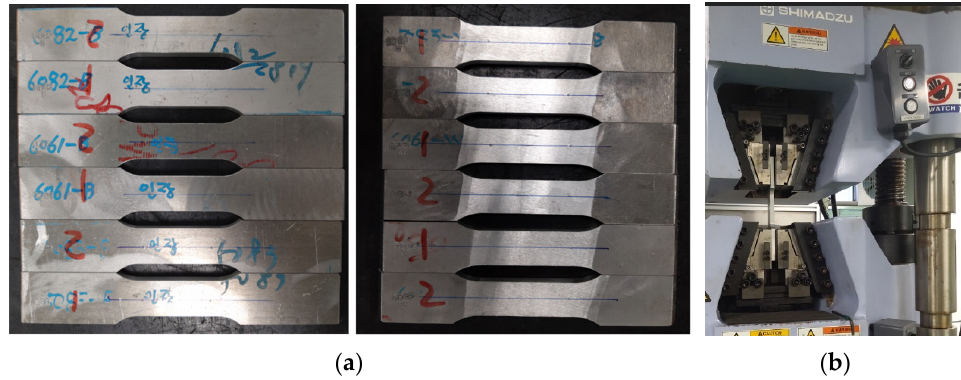
Figure 6. Tensile test of Al alloys: ( a ) Test specimens; ( b ) Tensile test machine.